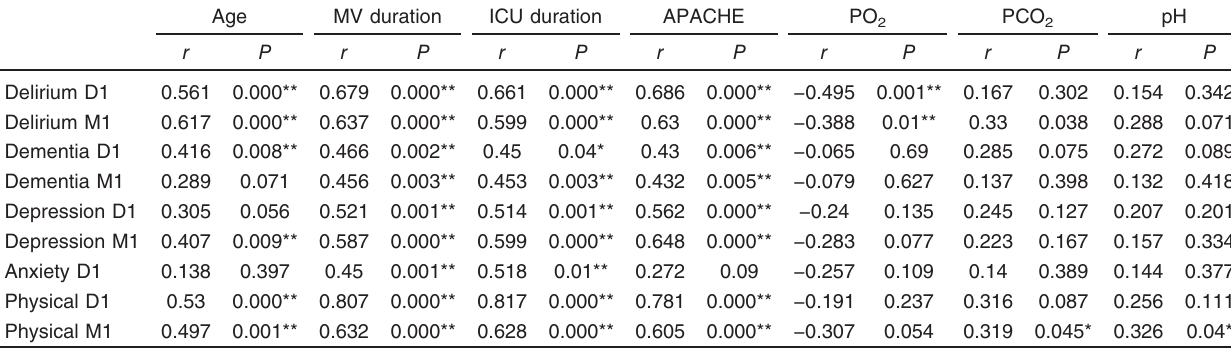
APACHE, acute physiology and chronic health evaluation; D1, day 1; M1, 1 month. *Significant. **Highly significant.